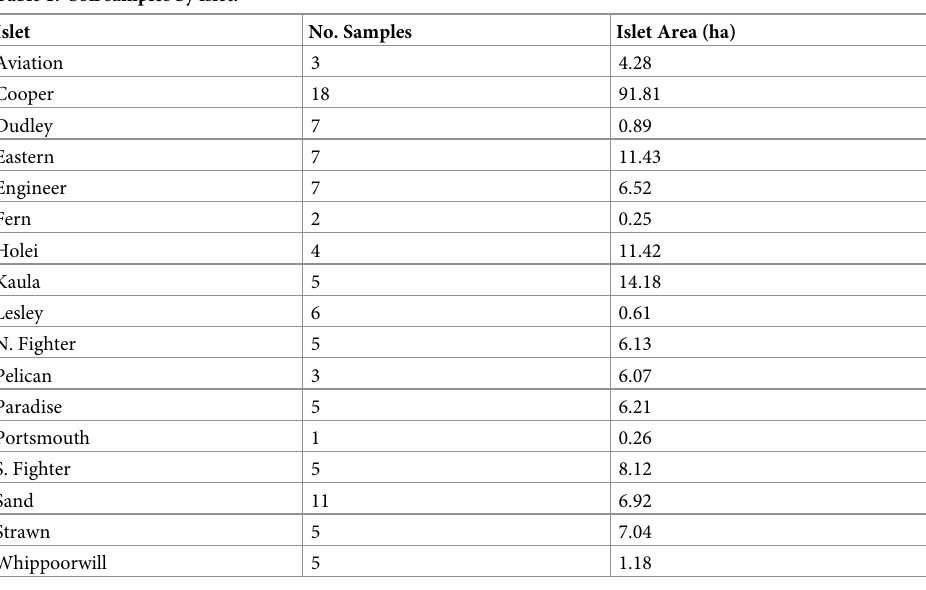
Table 1. Soil samples by